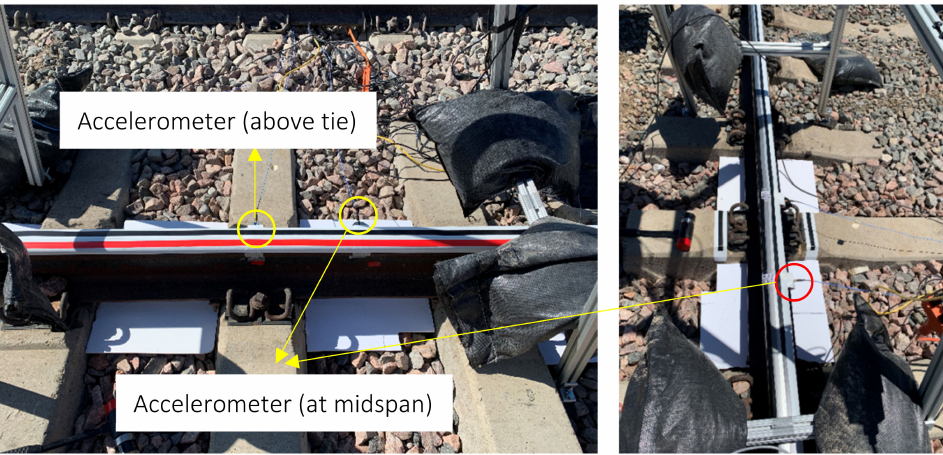
Figure 8. Close-up view of the rail on concrete ties tested in the field.